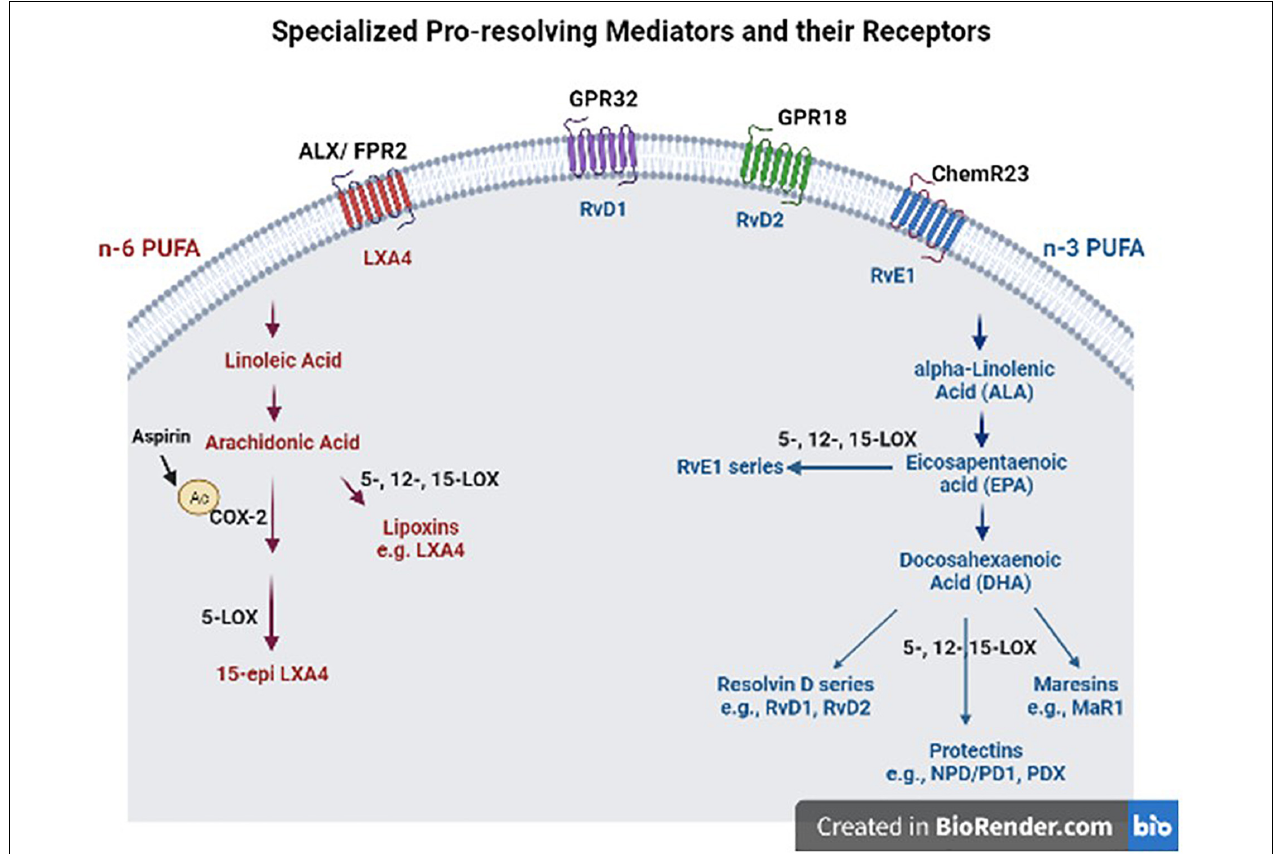
FIGURE 1 | Specialized pro-resolving mediators (SPM) and their receptors. These SPM are derived from omega (n)-3 and n-6 polyunsaturated fatty acids (PUFAS) in response to chemicals produced from acute inflammatory responses. ALX/FPR2, formyl peptide receptor 2; LXA4, lipoxin A4; GPR32, G protein-coupled receptor 32; RvD1, resolvin D1; GPR18, G protein-coupled receptor 18; RvD2, resolvin D2; ChemR23, chemerin receptor 23; RvE1, resolvin E1; COX-2, cyclooxygenase-2; LOX, lipoxygenase; MaR1, maresin 1; NPD/DP1, neuroprotectin/protectin